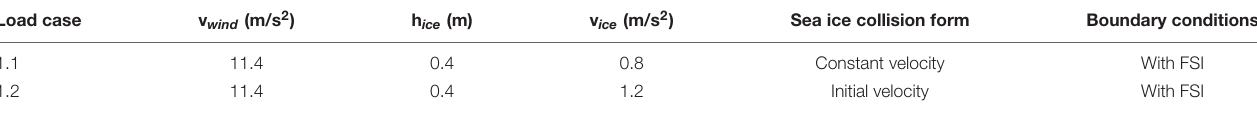
TABLE 7 | Load cases (LCs) to research ice-OWT interaction with